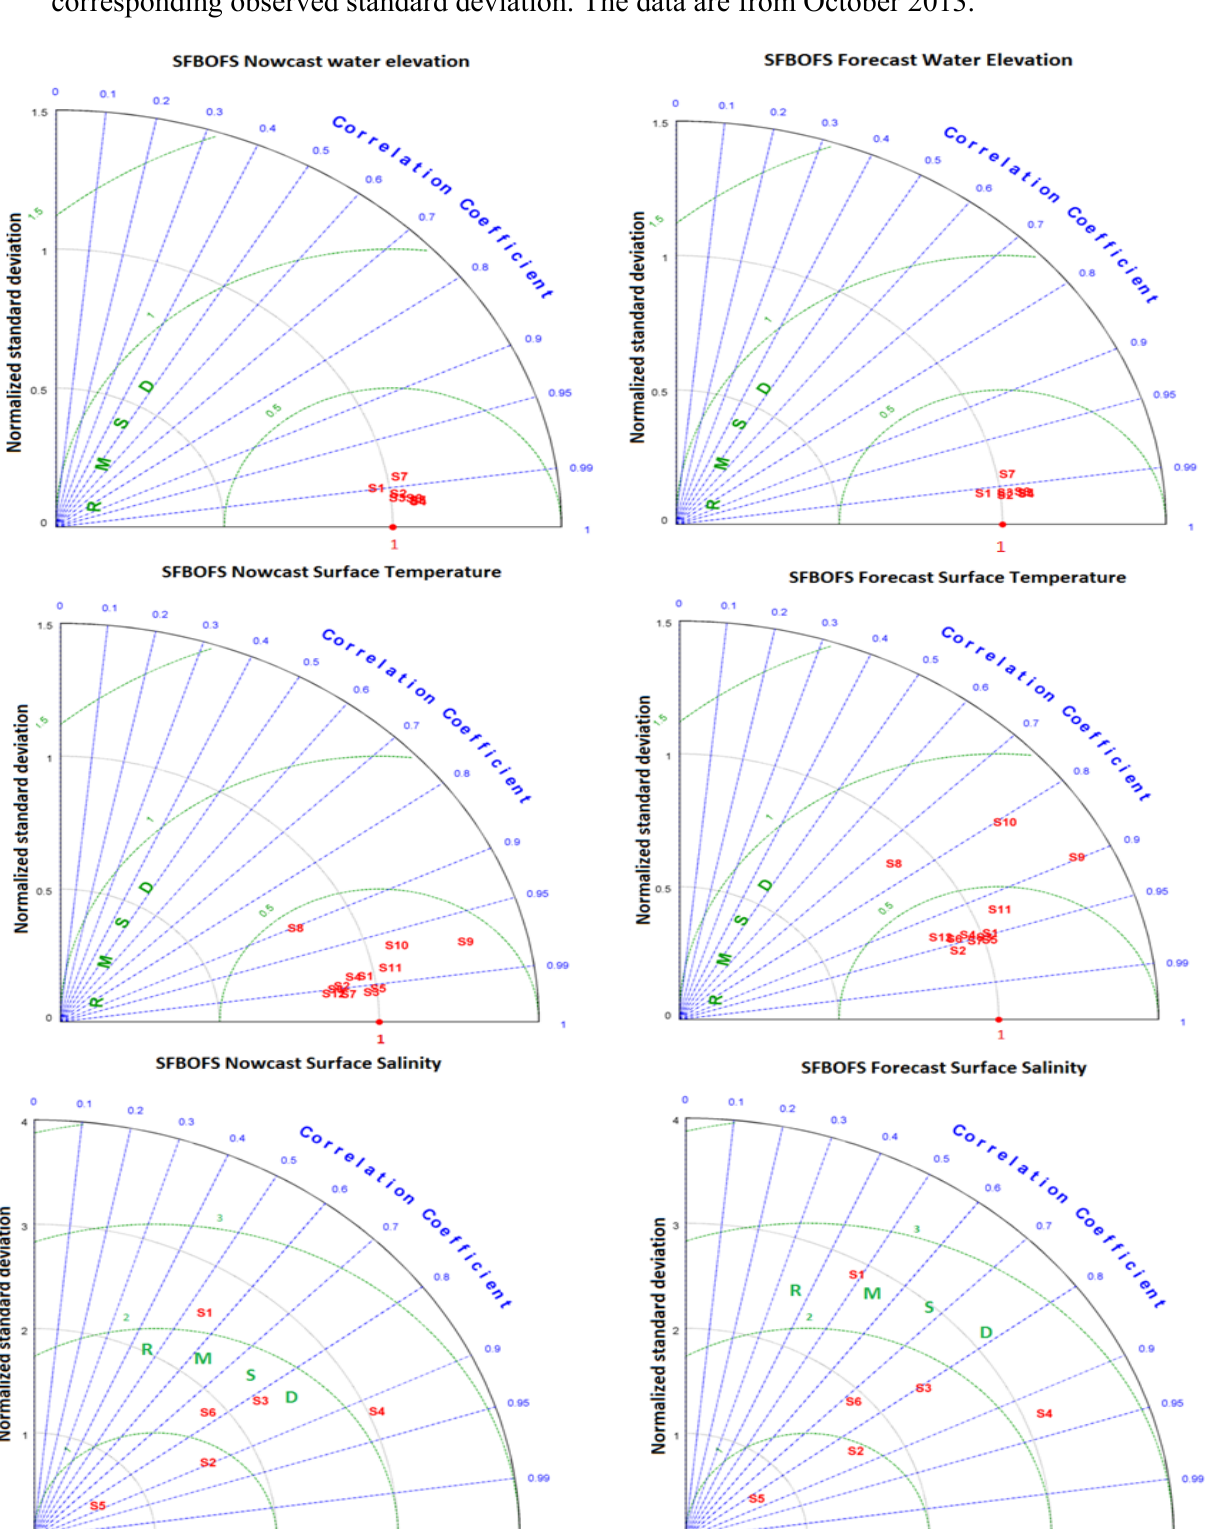
Figure 9. Normalized Taylor diagrams of water level, surface temperature and surface salinity for nowcast and forecast scenarios. S1, S2, S3, etc. are station series numbers. Si of water level, temperature and salinity does not necessarily indicate the same station. The modeled standard deviation of each variable at each station is normalized by its corresponding observed standard deviation. The data are from October